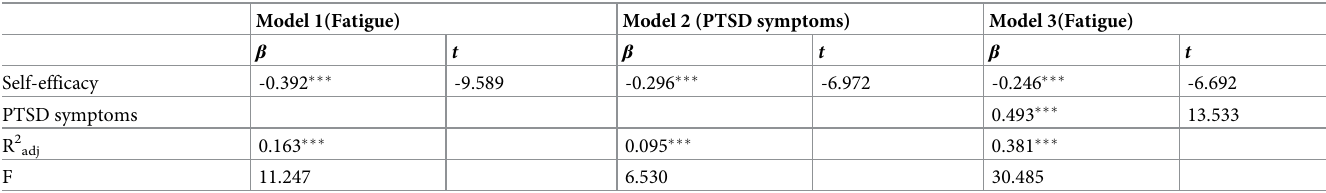
Table 3. Mediation analysis ( N =